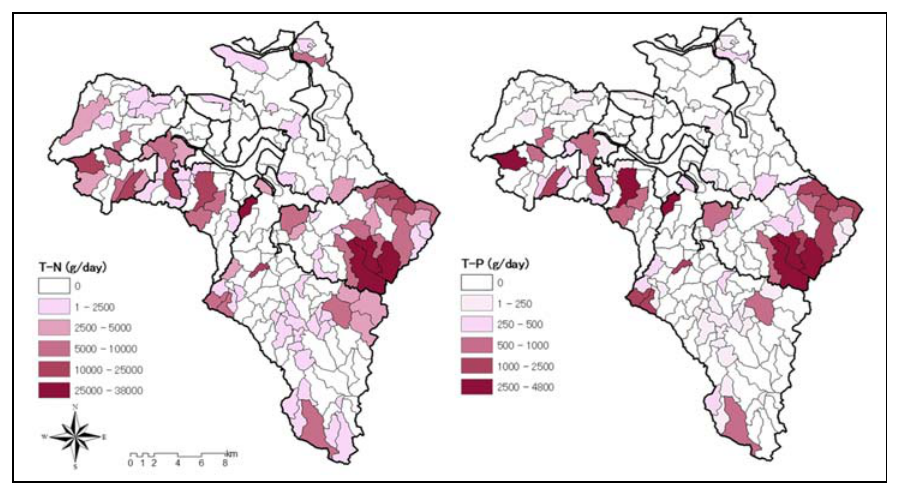
Figure 12. The amount of pollution loads of T-N and T-P after post-treatment of domestic wastewater in abandoned paddy fields for each sub-drainage